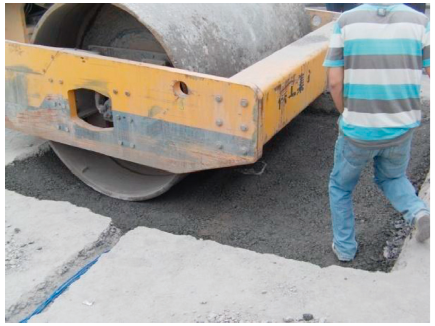
Figure 5: Protecting the FBG.